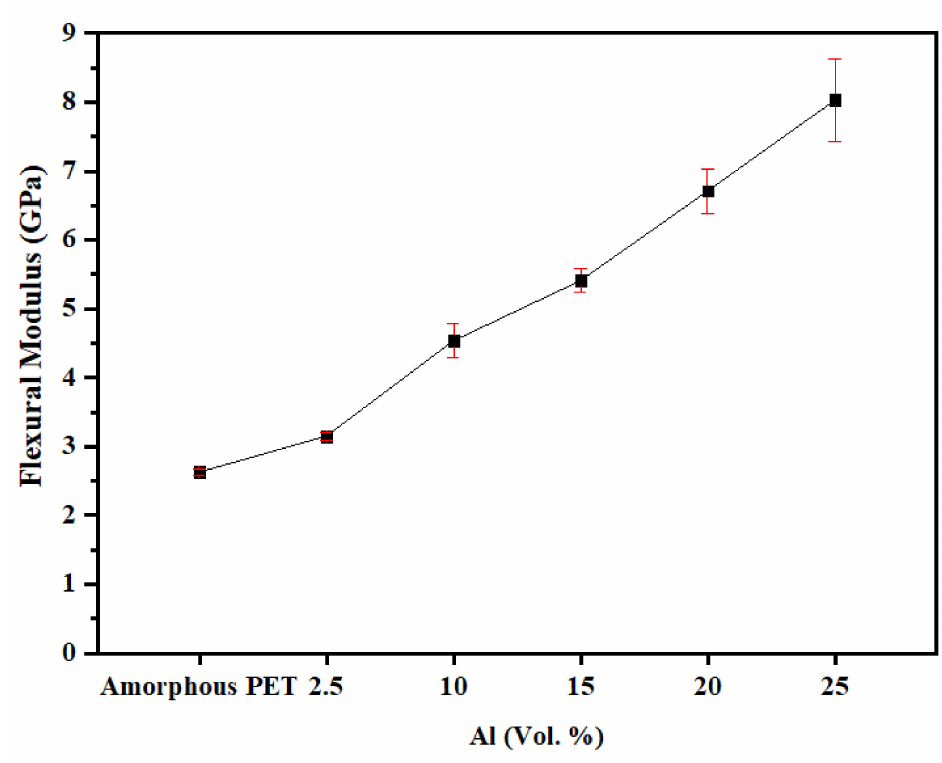
Figure 10. Flexural modulus of amorphous PET filled with Al nano